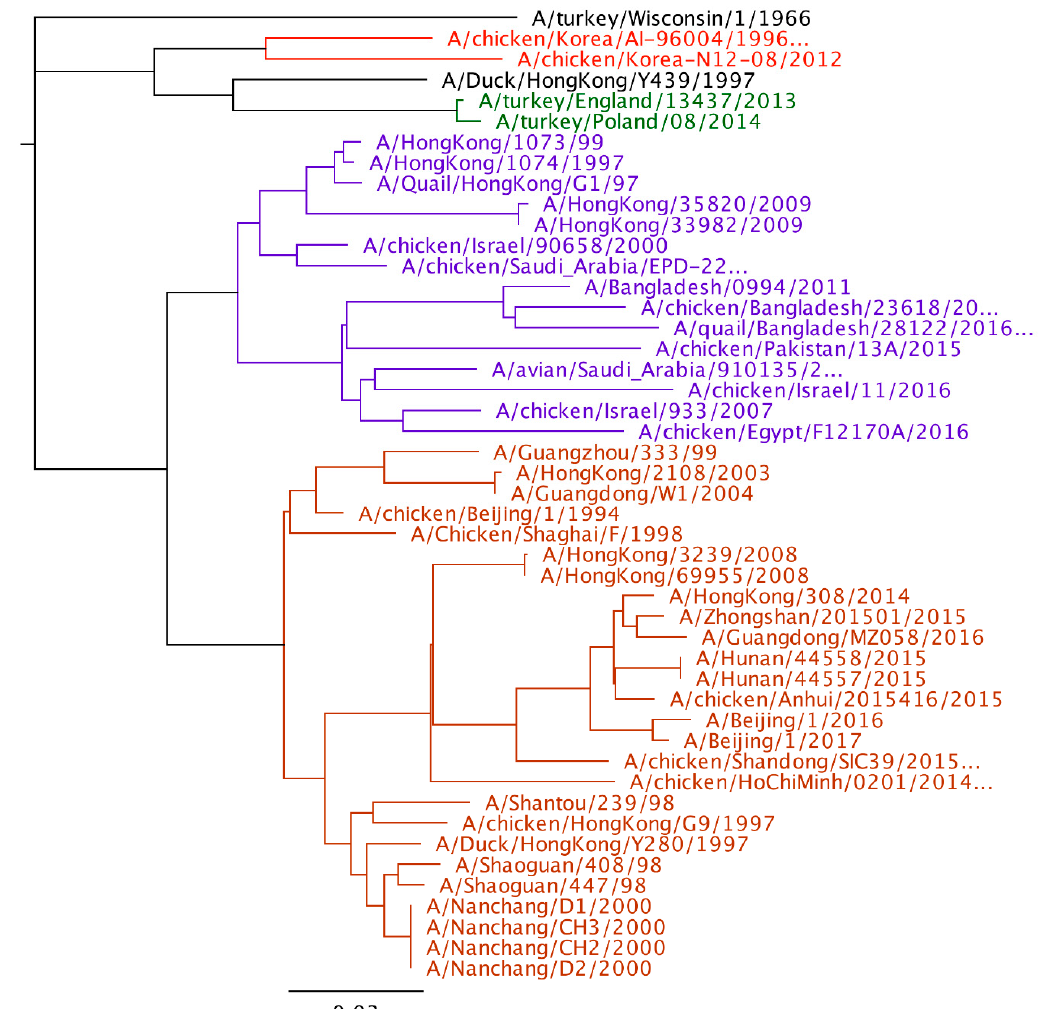
Figure 1. Phylogenetic tree of H9 hemagglutinin gene (Geneious 11.1.5). The four major poultry adapted lineages are color coded. Red-Korean lineage, Green-European lineage, Purple-G1, and Orange-Y280.